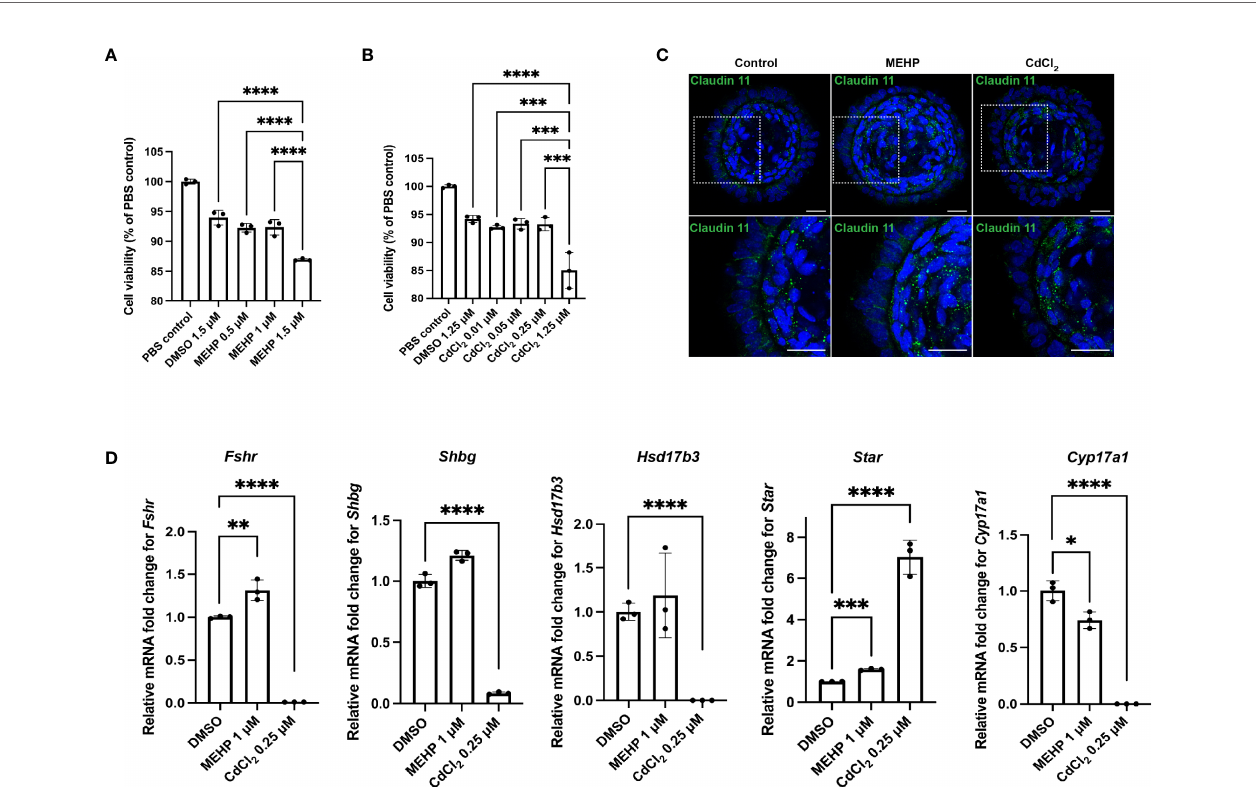
FIGURE 3 | Rat testicular organoids allow for modeling reproductive toxicity. (A, B) Relative cell viability of organoids after MEHP and CdCl 2 treatments. (C) Immuno fl uorescent images of day 21 rat testicular organoids treated with MEHP and CdCl 2 showing tight junction protein (Claudin 11) (inserts on the top panels are showing the magni fi ed area on the bottom panel). Scale bars measure 25 m m. (D) Relative mRNA fold change of Fshr , Shbg , Star , Hsd17b3 and Cyp17a1 in day 21 organoids after MEHP and CdCl 2 treatment. Bars indicate mean ± SD, n = 3. Analysis was performed using one-way ANOVA followed by Tukey ’ s multiple comparison test. p ≤ 0.05 (*), p ≤ 0.01 (**), p ≤ 0.001 (***), p ≤ 0.0001 (****). Only signi fi cant differences are indicated with